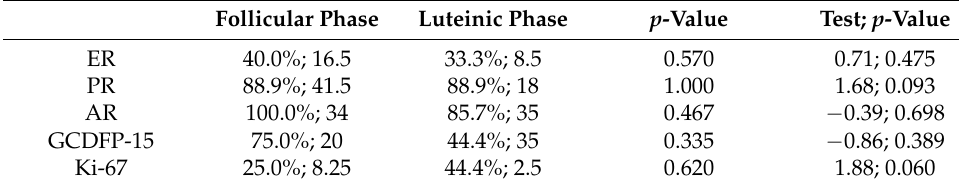
Table 4. Expression of hormone receptors according to menstrual cycle.